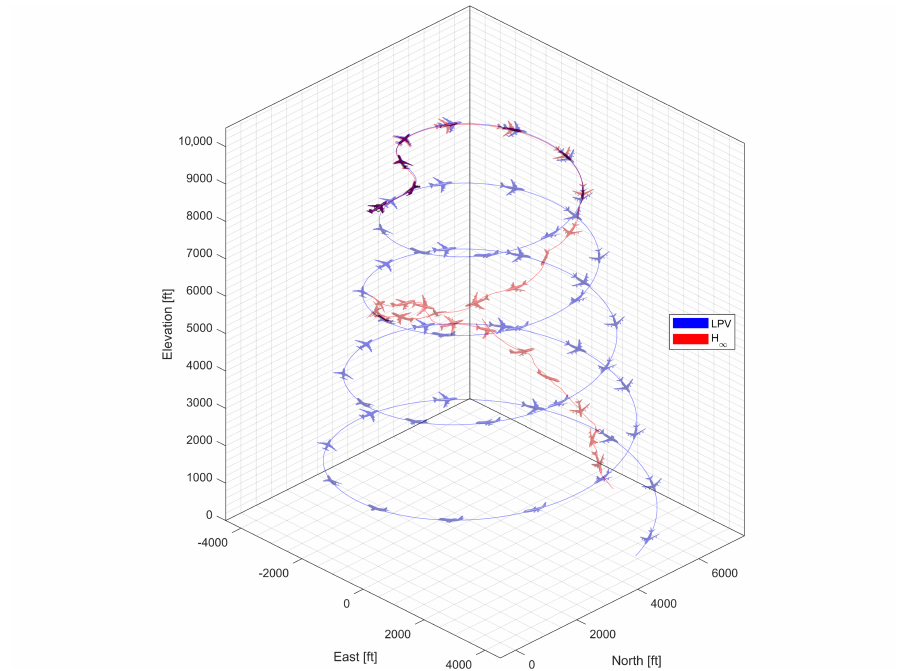
Figure 29. Flight trajectory of the spiral